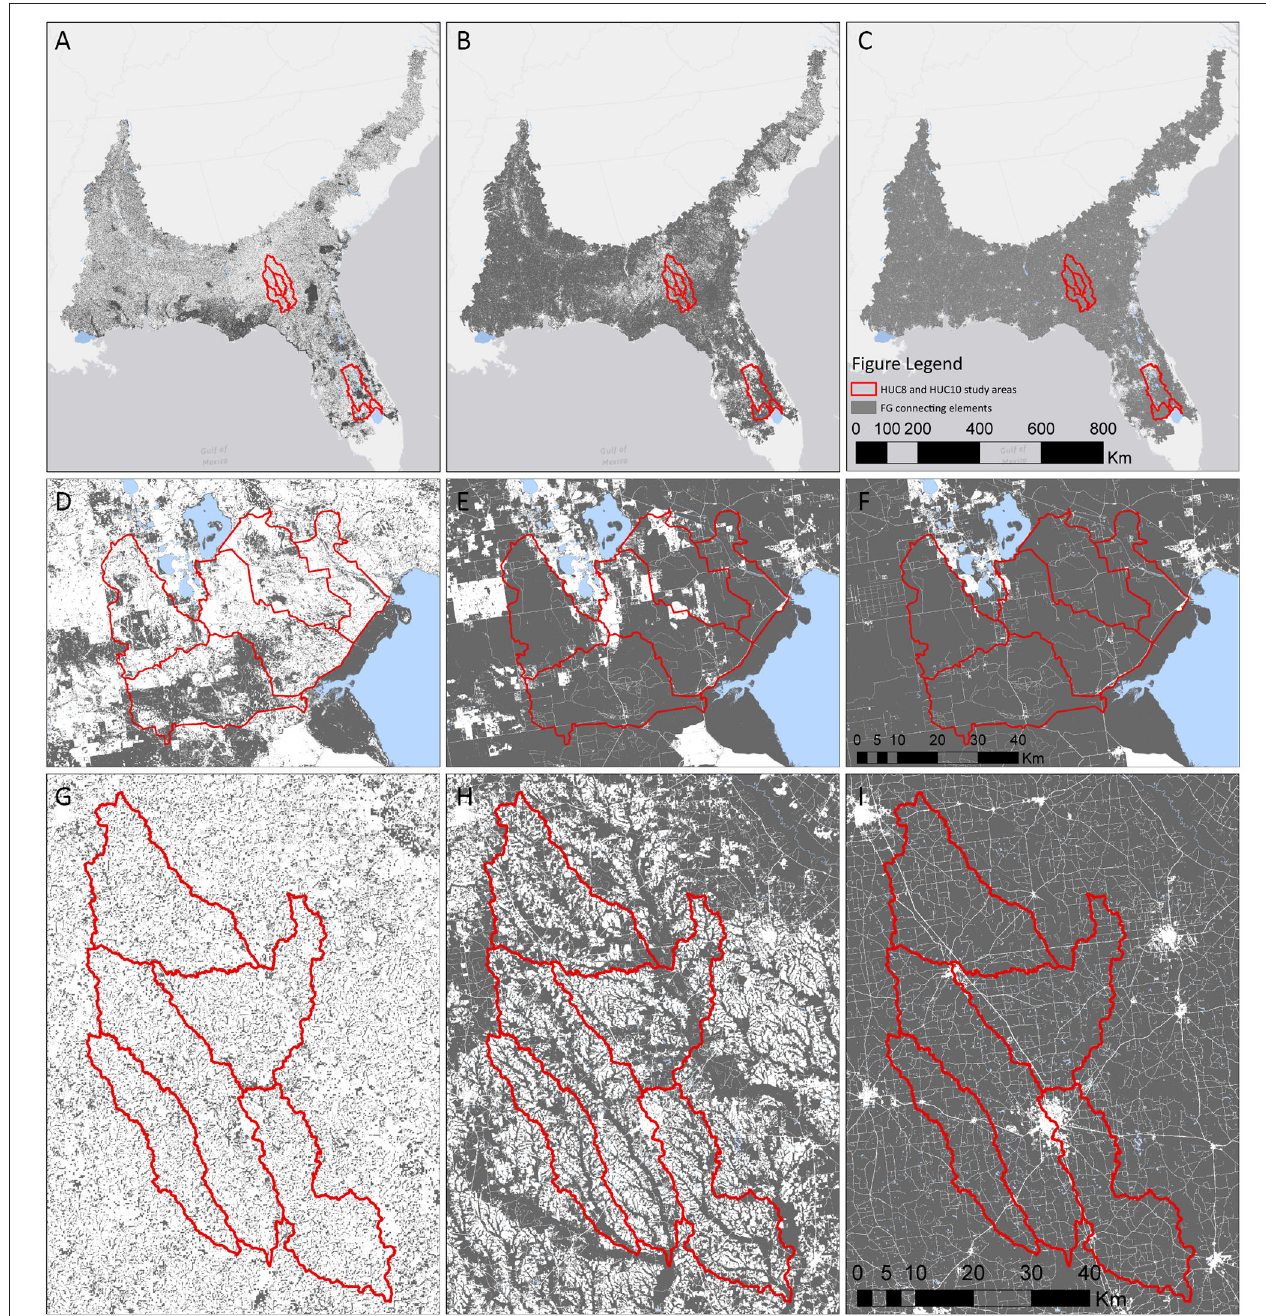
FIGURE 4 | Land use fragmentation geometries (FGs) in the southeastern US (top row), Florida (center row), and Georgia (bottom row), with increasing intensity of use (columns). Left column shows FG1, consisting of wetlands, shrublands and unmanaged forests (gray) for the Southeast (A) , Florida (D) , and Georgia (G) . Middle column shows FG2, consisting of areas in FG1 plus all forests, shrublands, grasslands, and hay production areas (gray) for the Southeast (B) , Florida (E) , and Georgia (H) . Right column shows FG3, consisting of areas in FG2 plus croplands (gray), for the Southeast (C) , Florida (F) , and Georgia (I) , so that areas excluded (white) are developed and open water land cover classes. See Supplementary Material 1 for land cover classification and GIS workflow.